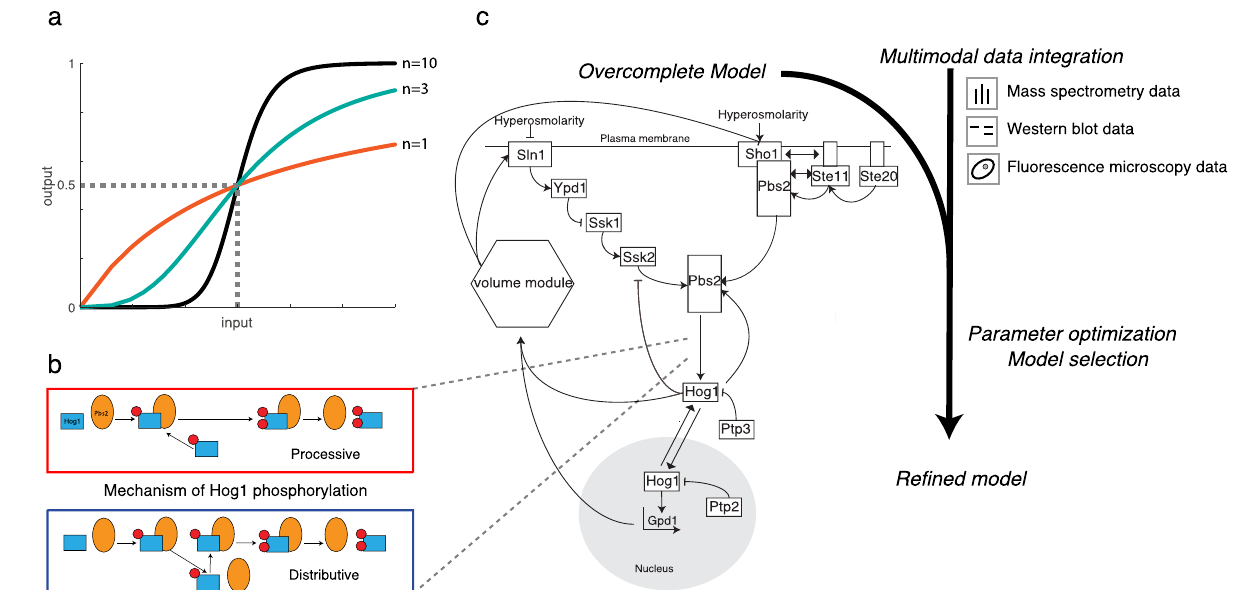
Fig. 1 | Generation of an overcomplete model of the Hog1 pathway and para- meter optimization. a A Hill function quanti fi es input-output behavior as highly ultrasensitive (blackline,Hillcoef fi cient = 10), mildly ultrasensitive (greenline, Hill coef fi cient = 3), or strictly Michaelian (red line, Hill coef fi cient = 1). EC50 value (dashed line) indicates the input strength at which 50% of the maximal output is reached. b ThechoiceofHog1phosphorylationmechanismhasasigni fi cantimpact on the resulting input-output behavior and can be mainly processive or dis- tributive. For the processive mechanism, the second phosphorylation step imme- diatelyfollows the fi rst without Hog1 disassociating from Pbs2.Forthe distributive mechanism Hog1 disassociates from Pbs2 after every phosphorylation step and needs to re-bind for further phosphorylation to take place. c Simpli fi ed scheme of